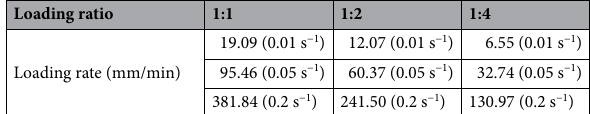
Table 2. Loading rate under different loading conditions.